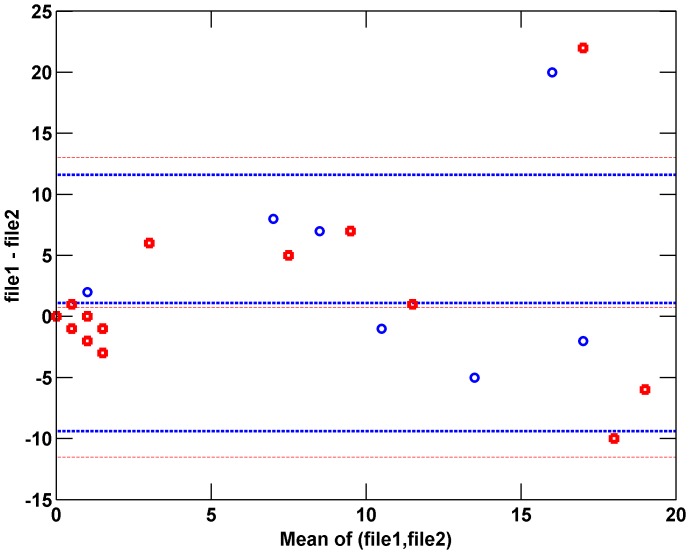
Bland-Altman plot comparing repeatability of semi-automated results (blue circles) to repeatability of nurse findings (red squares).In this comparison, the first and second files for each day (‘file1’ and ‘file2’) were compared. Repeatability is similar for nurse assignments and semi-automated algorithm results.